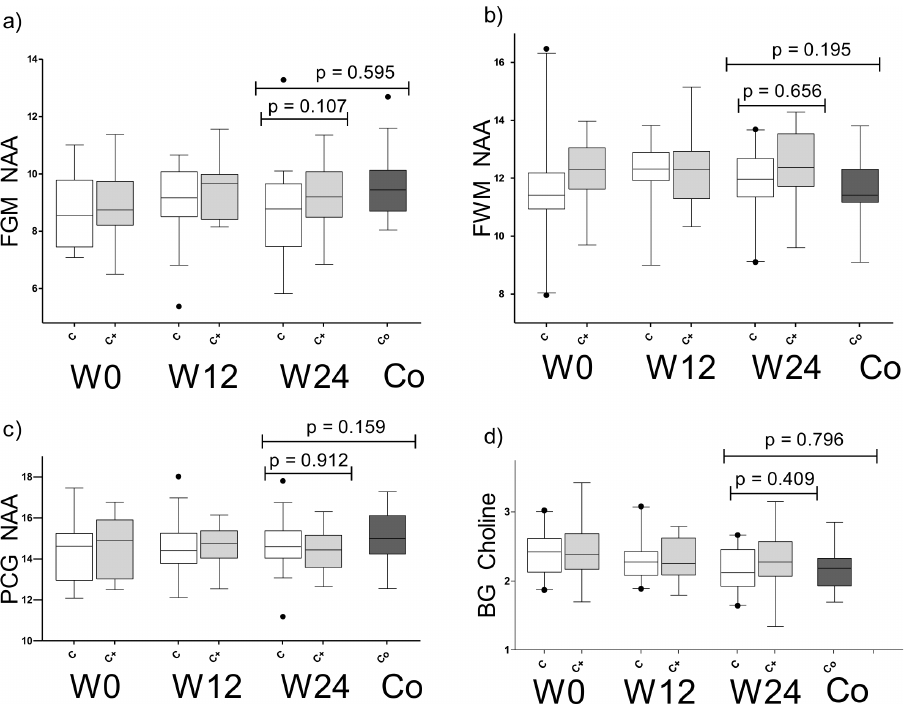
Fig 2. NAA and Cho changes with treatment cART (white) vs. cART+ (grey) compared to controls (black). (a) Frontal grey matter (b) Frontal white matter (c) Posterior cingulate gyrus (d) Basal ganglia.